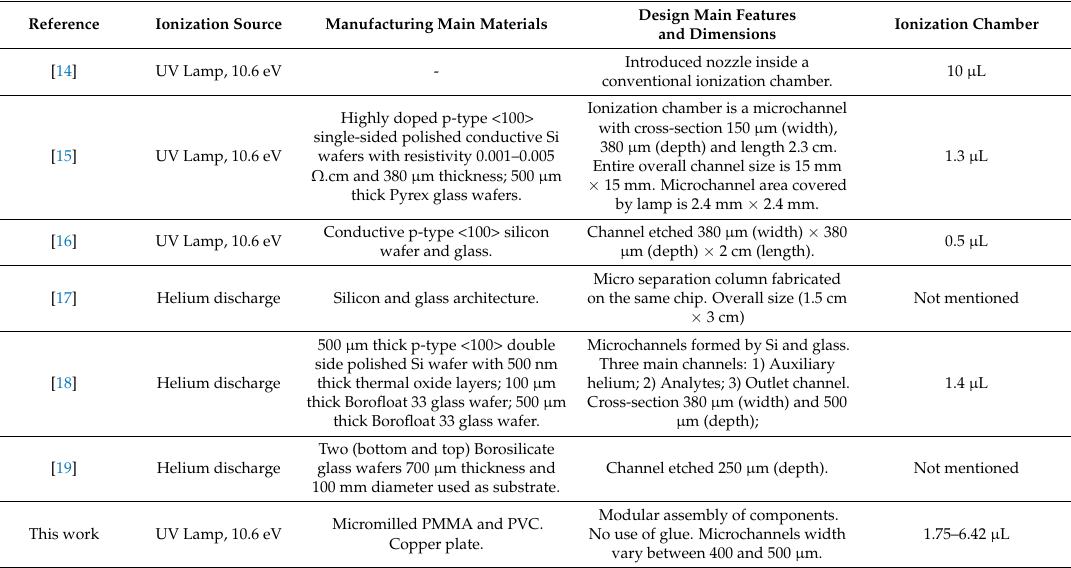
Table 1. Main works on microfluidic photoionization detector ( µ